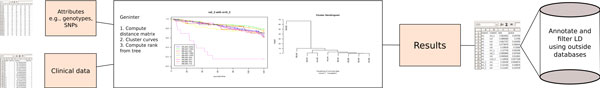
The outline of the Geninter analysis workflow. First, an attribute matrix containing genotypes and a matrix of survival times are given as an input to Geninter. The analysis is divided into three steps. The results (sorted list of SNP-pairs) can then be 12 annotated, for instance, using the Ensembl database and filtered to exclude markers that are in linkage disequilibrium (LD). The output contains the marker pairs, their ranks and p-values.